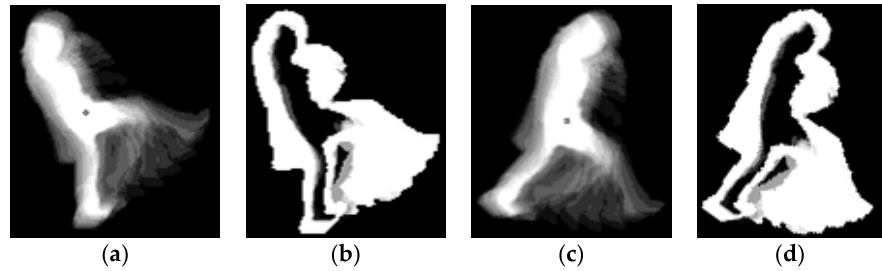
Figure 15. Examples of cases in which the GEI-based method produced an erroneous recognition result. Kicking images by ( a ) GEI; and ( b ) EGEI; running or walking image by ( c ) GEI; and ( d ) EGEI.